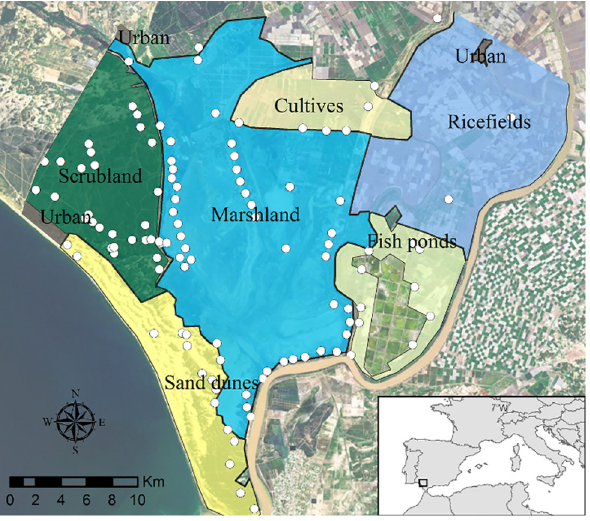
Fig 1. Map of the study area with an ortophotograph of the area. Ecological units are described in Material and Methods. Urban areas correspond to the villages situated at the border of the study area. White circles indicate the locations of the